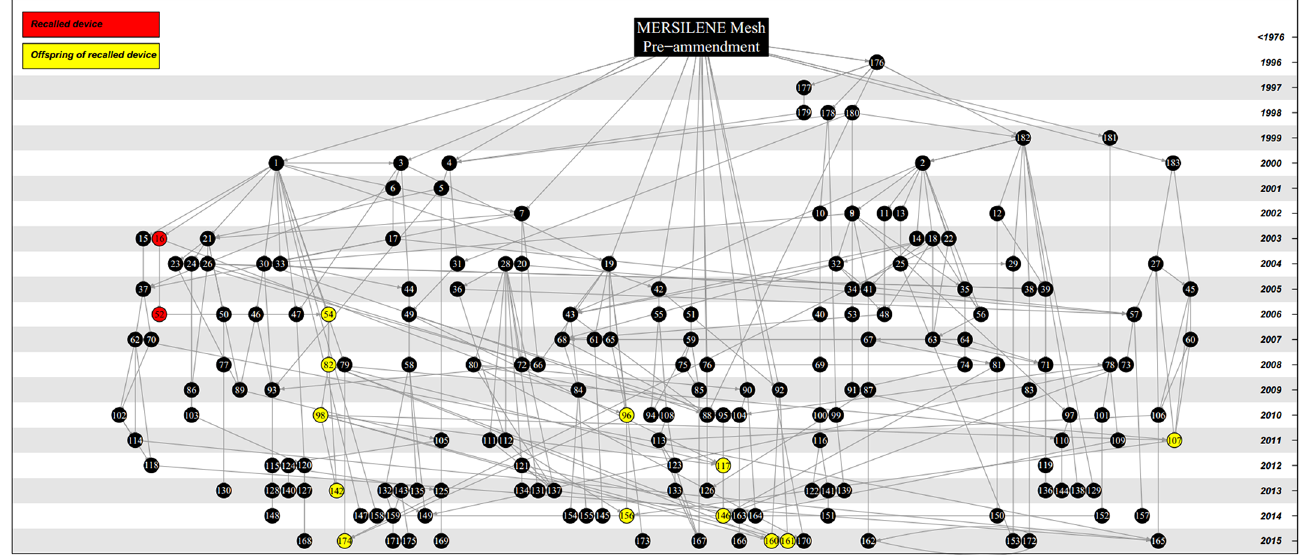
Fig 3. The ancestral device network of Mersilene Surgical Mesh manufactured by Ethicon Inc. Mersilene Mesh has led to 183 descendent devices. Devices in the ancestral network that have since been recalled for ‘design and material related flaws’ (n = 2) are highlighted in red. Devices that are descended from recalled devices by substantial equivalency chains (n = 12) are highlighted in yellow (see S2 Data for devices).